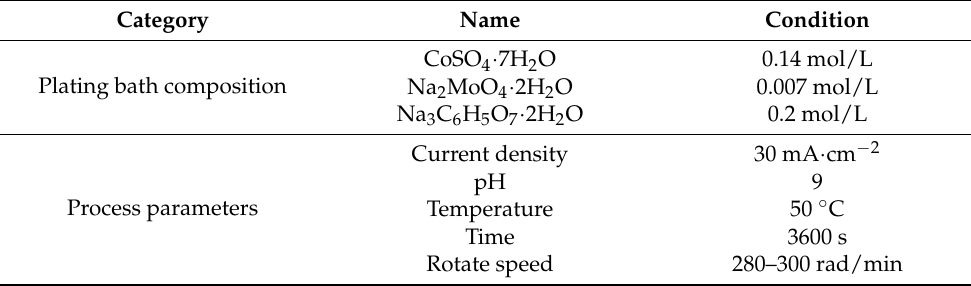
Table 5. Optimum technological parameters of Co-Mo alloy coating preparation.